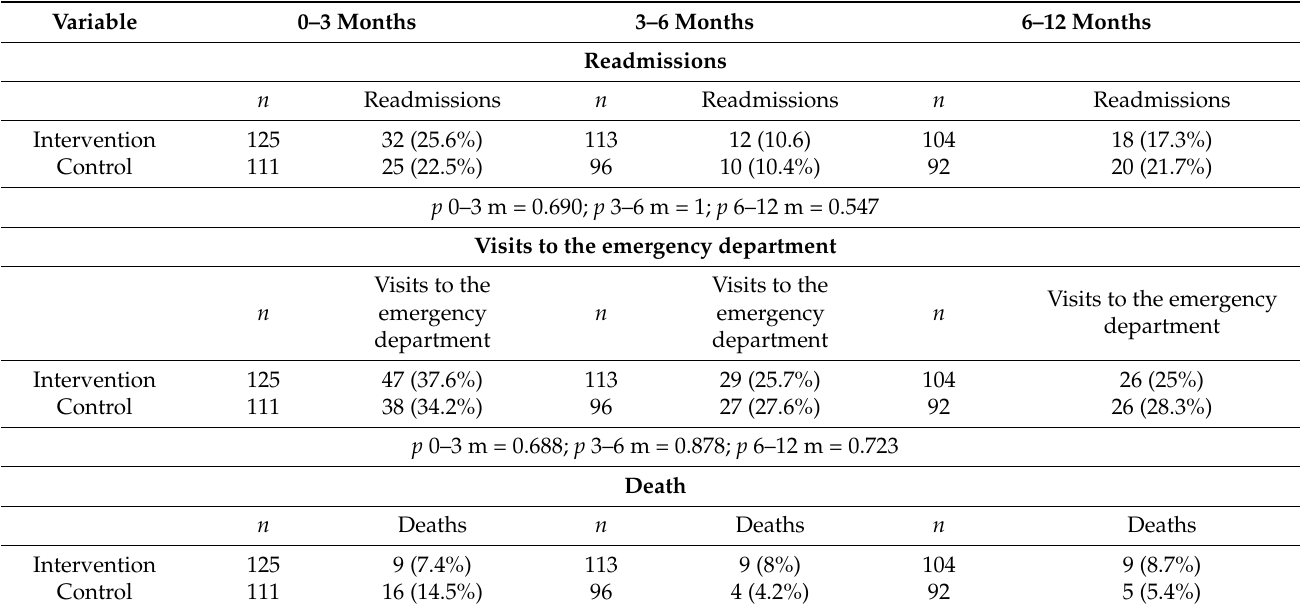
Table 6. Comparison of readmissions, emergency department visits, and deaths during the